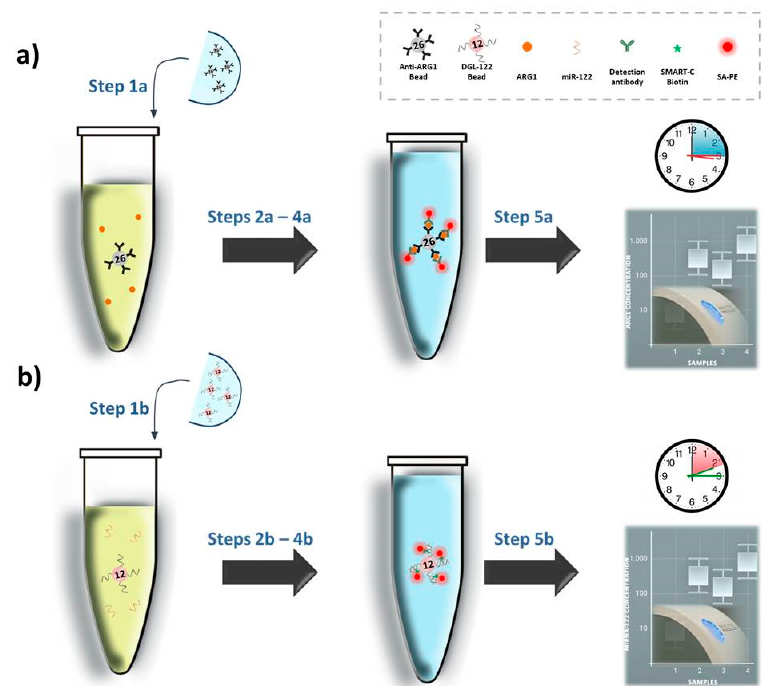
Figure 1. Singleplex workflows. ( a ) Analysis of ARG1: Step 1a—anti-ARG1 beads are added to the